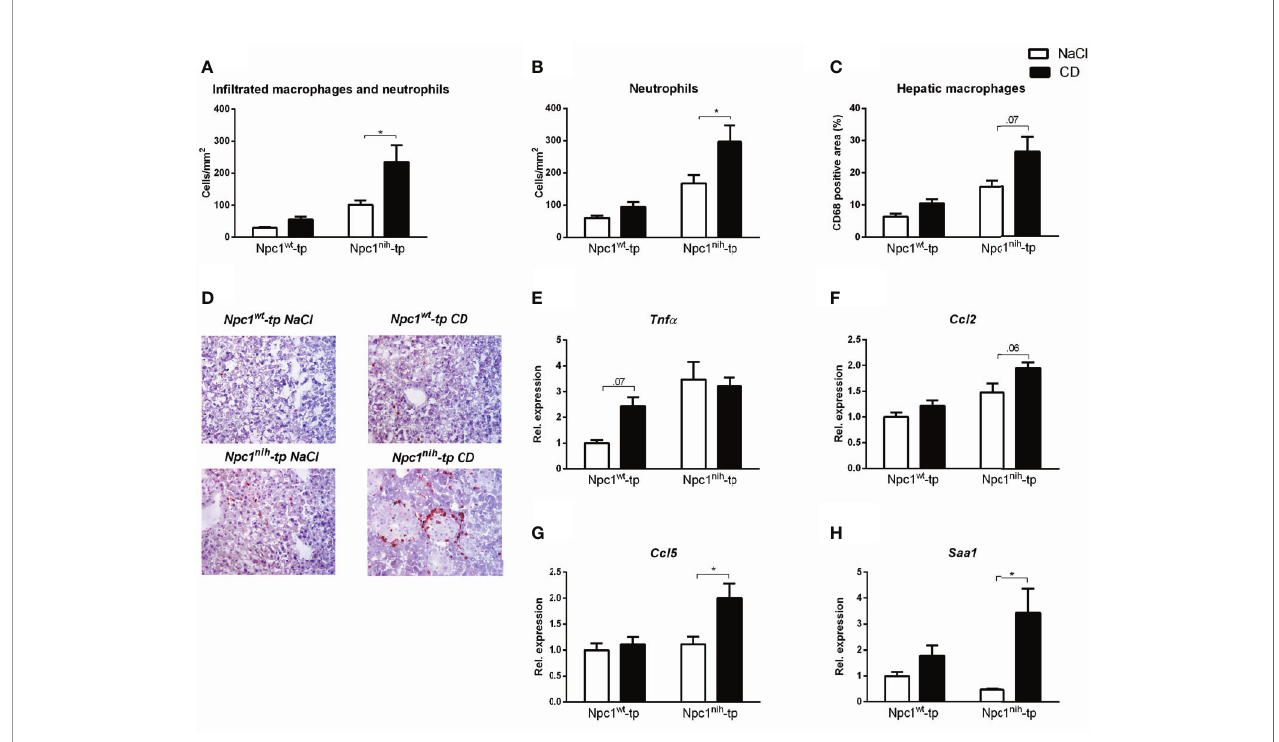
FIGURE 2 | Parameters of hepatic in fl ammation. (A – C) Liver sections were stained for in fi ltrating macrophages and neutrophils (Mac-1), neutrophils (NIMP) and hepatic macrophages (CD68) and subsequently quanti fi ed by counting (Mac-1 and NIMP) or by assessing the positive area of the staining (CD68). (D) Representative images of liver sections stained for in fi ltrated macrophages and neutrophils (Mac-1). (E – H) Hepatic gene expression analysis of Tnf a , Ccl2, Ccl5 and Saa1 . Gene expression data were set relative to control-treated Npc1 wt -tp mice. * indicates p ≤ 0.05 by means of two-way ANOVA followed by Tukey post-hoc